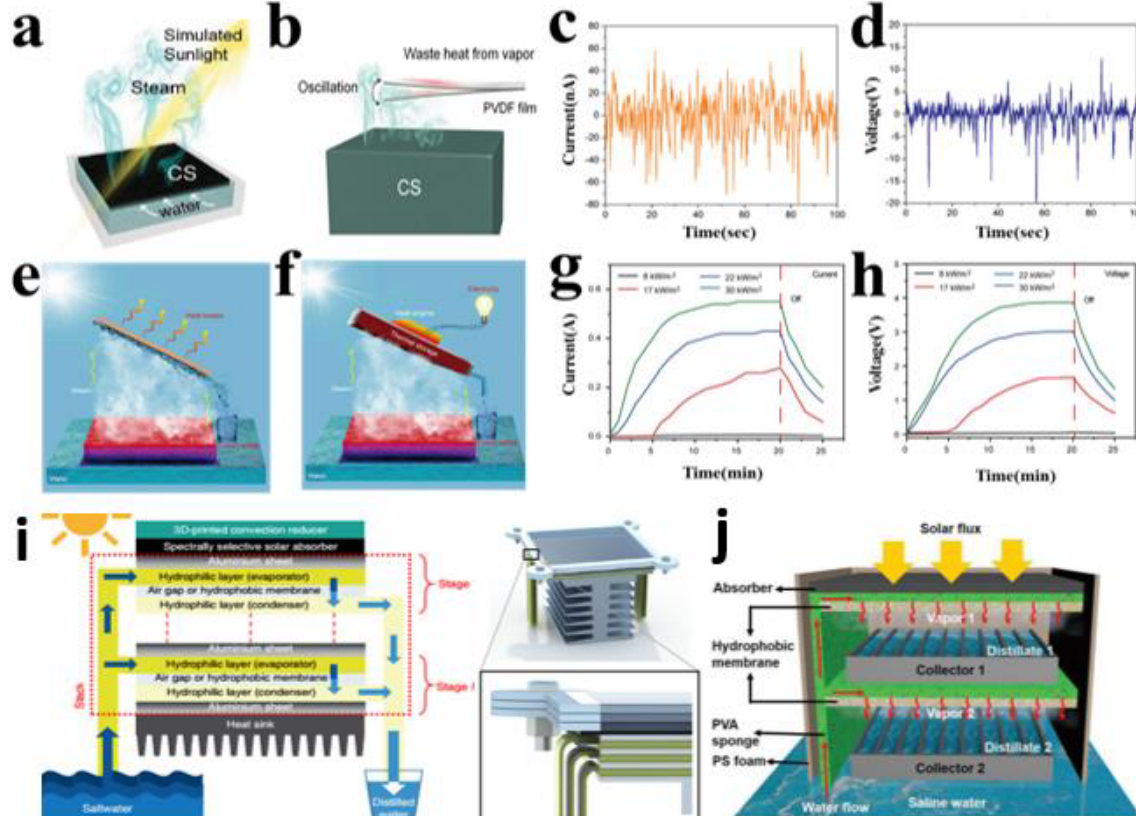
Figure 10: Thermal management of latent heat reuse: (a) solar steam generation; (b) steam generation-induced electric; (c) the piezo- pyroelectric output currents and (d) voltages [122]; (e) condensation processes; (f) storage and recycling of solar steam enthalpy; (g) open- circuit voltage and (h) short-circuit current [123]; (i) schematic of the modular distiller [125]; (j) schematic of high-eflcient solar-thermal membrane distillation system